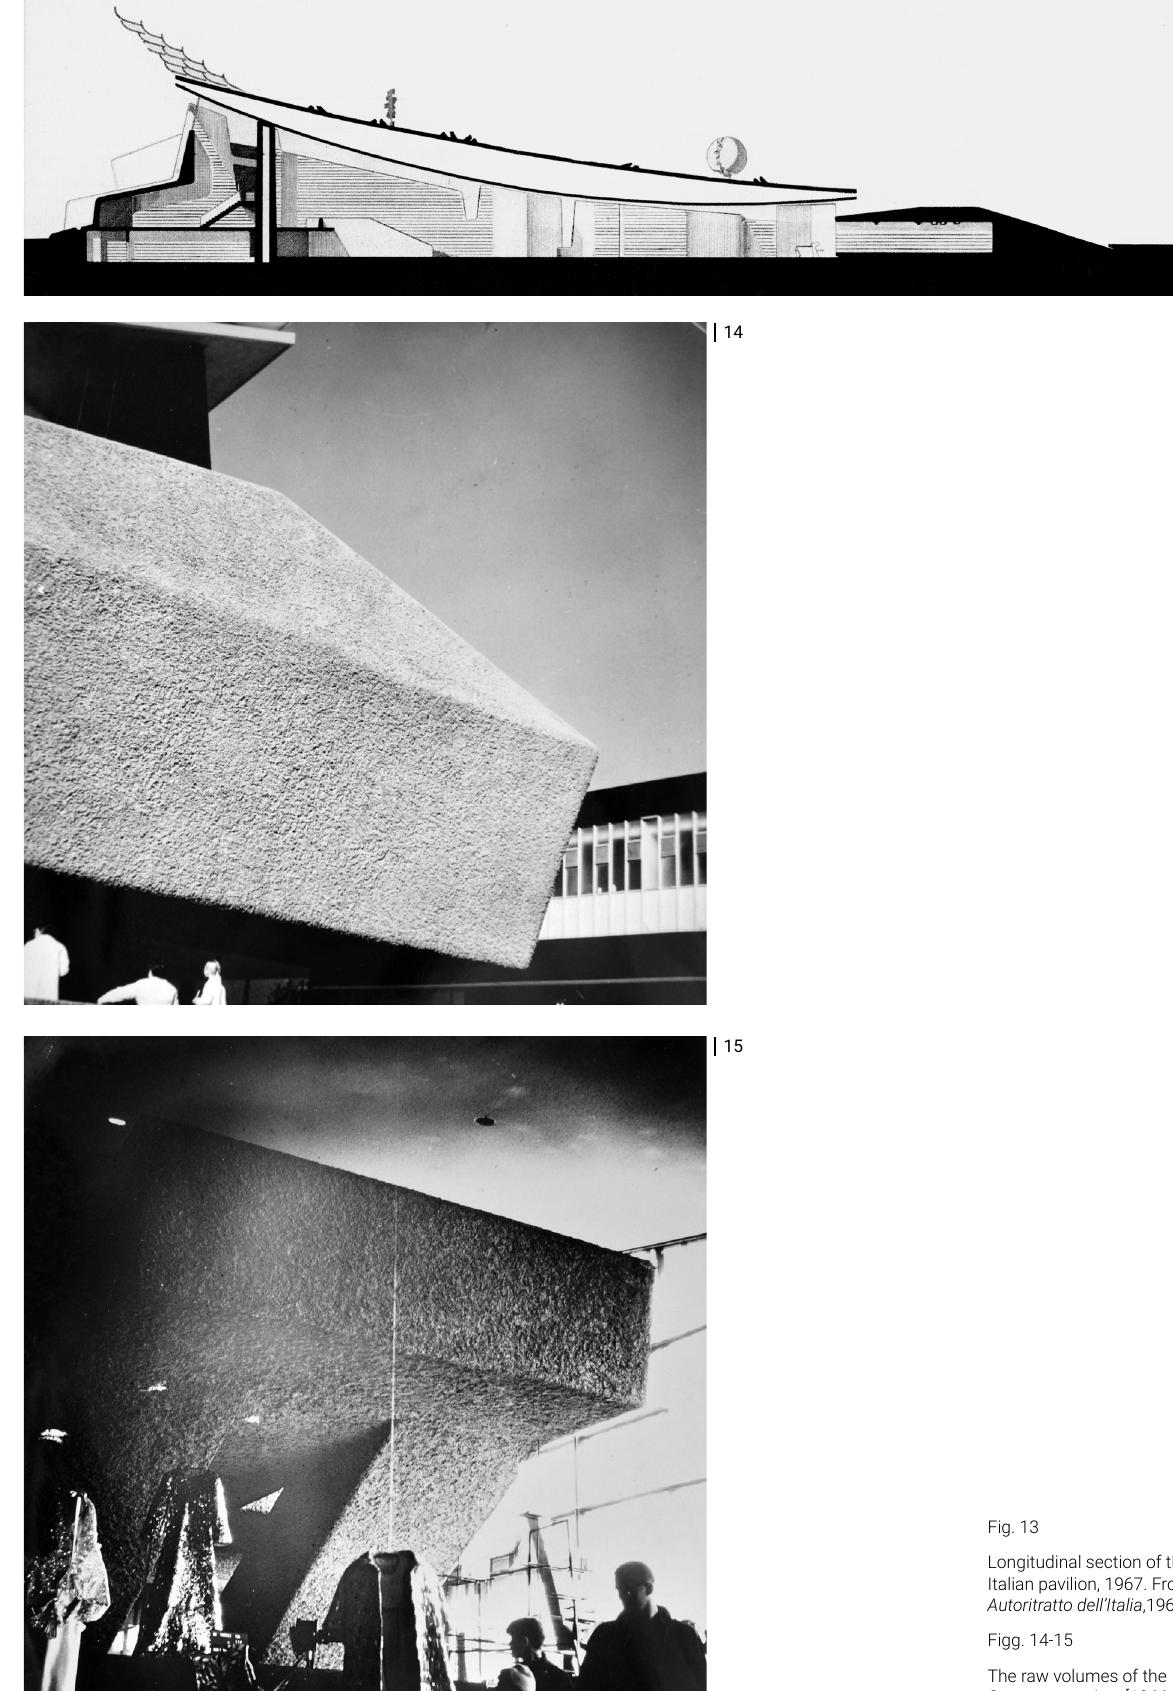
Fig. 13 Longitudinal section of the Italian pavilion, 1967. From Autoritratto dell’Italia ,1967. Figg. 14-15 The raw volumes of the Costume section, [1966-67]. Fotografie. Ricci Studio House - Monterinaldi